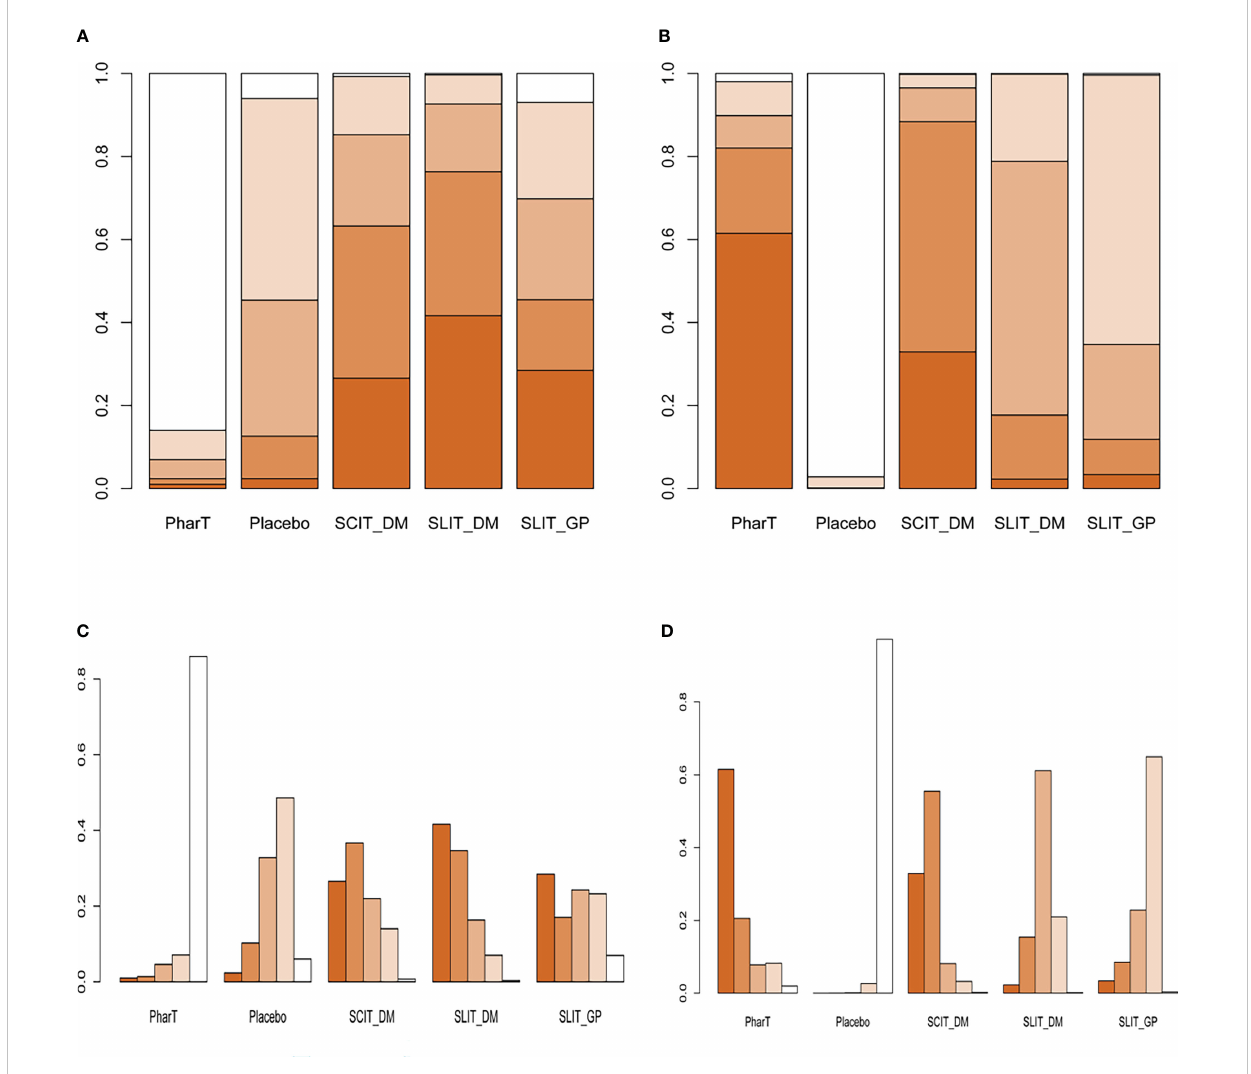
FIGURE 6 (A) Stacking diagram of symptom scores. (B) Stacking diagram of adverse reactions. (C) Single ranking diagram of symptom scores. (D) Single ranking diagram of adverse reactions. PharT, pharmacotherapy; SCIT, subcutaneous immunotherapy; SLIT, sublingual immunotherapy; DM, dust mite; GP, grass mix plus pollen